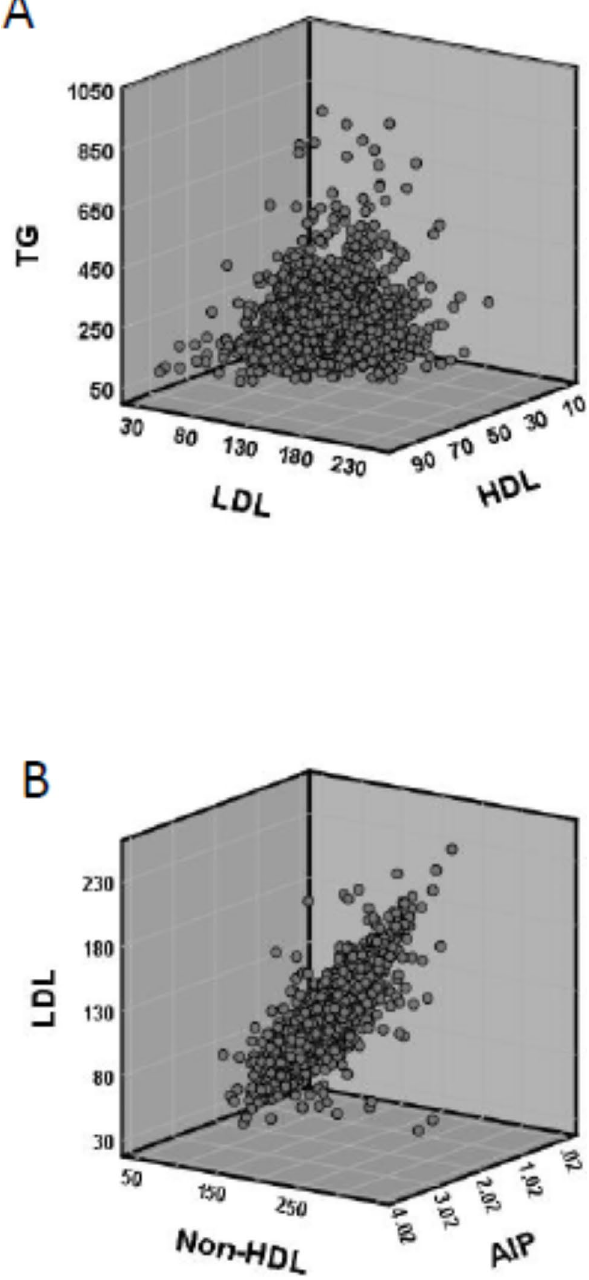
Fig. 2 Relationship between blood lipid profile components. 3-D Scat- terplots were used to demonstrate the relationship between (A) TG, LDL, HDL, and (B) LDL, non-HDL, AIP. The drawn patterns show that the blood lipid levels are not within the optimal range TG: triglyceride; LDL: low-density lipoprotein; HDL: high-density lipopro- tein; non-HDL: non-high-density lipoprotein (Total cholesterol minus HDL- C); AIP: atherogenic index of plasma (log